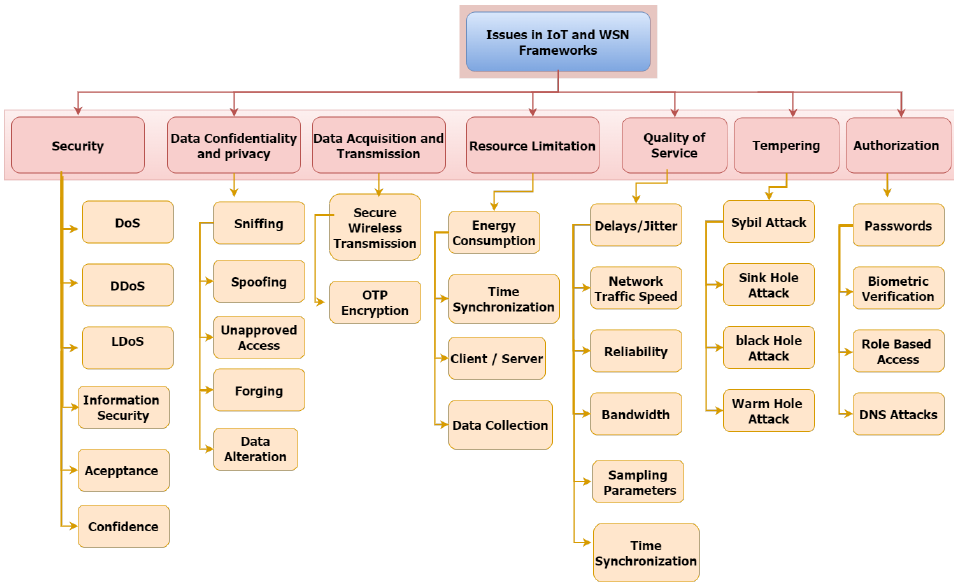
Figure 9. Issues in WSN and IoT